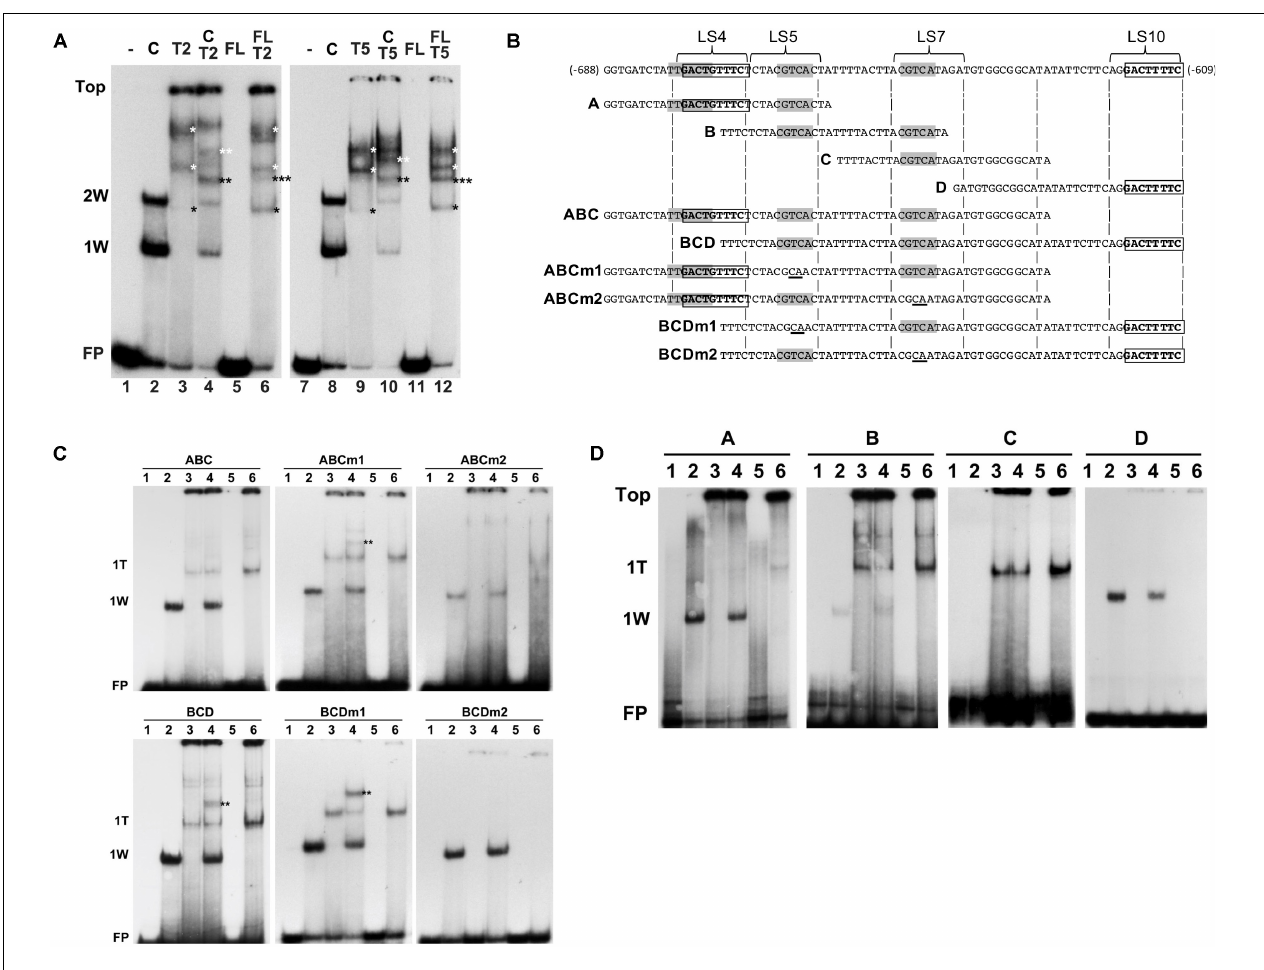
FIGURE 6 | AtWRKY50 and TGA2 and TGA5 bind to the PR1 promoter. (A) EMSAs were performed with an 80-bp fragment of the PR1 promoter without protein (minus signs) or with GST-tagged C-terminal half (C) or full-length (FL) versions of AtWRKY50, and His-tagged TGA2 (T2) or TGA5 (T5), and combinations of these proteins, as indicated above the lanes. The positions of the unbound probe (FP), the top of the gel (Top), and of band shifts caused by one (1W) or two (2W) AtWRKY50-C proteins are indicated at the left. Shifts caused by binding of single (single black asterisks) or multiple (single white asterisks) TGA proteins and shifts caused by a combination of TGA and AtWRKY50 (double black asterisks) are indicated. (B) Sequences of PR1 promoter fragments used for electromobility shift assays. Overlapping subfragments A, B, C, and D, and subfragments ABC and BCD are aligned with the sequence of the 80-bp fragment. The overlapping W-box (TTGACT) and AtWRKY50 binding sequence (GACTGTTTC) in LS4, the CGTCA boxes of the as-1 element in LS5 and LS7, and the AtWRKY50 binding sequence (GACTTTTC) in LS10 are indicated in bold. Subfragments ABCm1, ABCm2, BCDm1 and BCDm2 represent variants of fragments ABC and BCD with mutations (underlined) in the CGTCA boxes in LS5 and LS7, respectively. (C) EMSAs were performed with probes corresponding to PR1 promoter fragments ABC and BCD and their mutated versions ABCm1, ABCm2, BCDm1, BCDm2, as indicated above the panels. EMSA incubation mixtures contained no protein (Lanes 1), AtWRKY50-C (Lanes 2), TGA2 (Lanes 3), AtWRKY50-C and TGA2 (Lanes 4), full-length AtWRKY50 (Lanes 5), and full-length AtWRKY50 and TGA2 (Lanes 6). The positions of the unbound probe (FP) and of band shifts caused by AtWRKY50-C (1W) or TGA2 (1T) are indicated at the left. Shifts caused by binding of a combination of TGA and AtWRKY50 (double black asterisks) are indicated. (D) EMSAs were performed with PR1 promoter fragments A, B, C, and D as probes, as indicated above the panels. EMSA incubation mixtures contained no protein (Lanes 1), AtWRKY50-C (Lanes 2), TGA2 (Lanes 3), AtWRKY50-C and TGA2 (Lanes